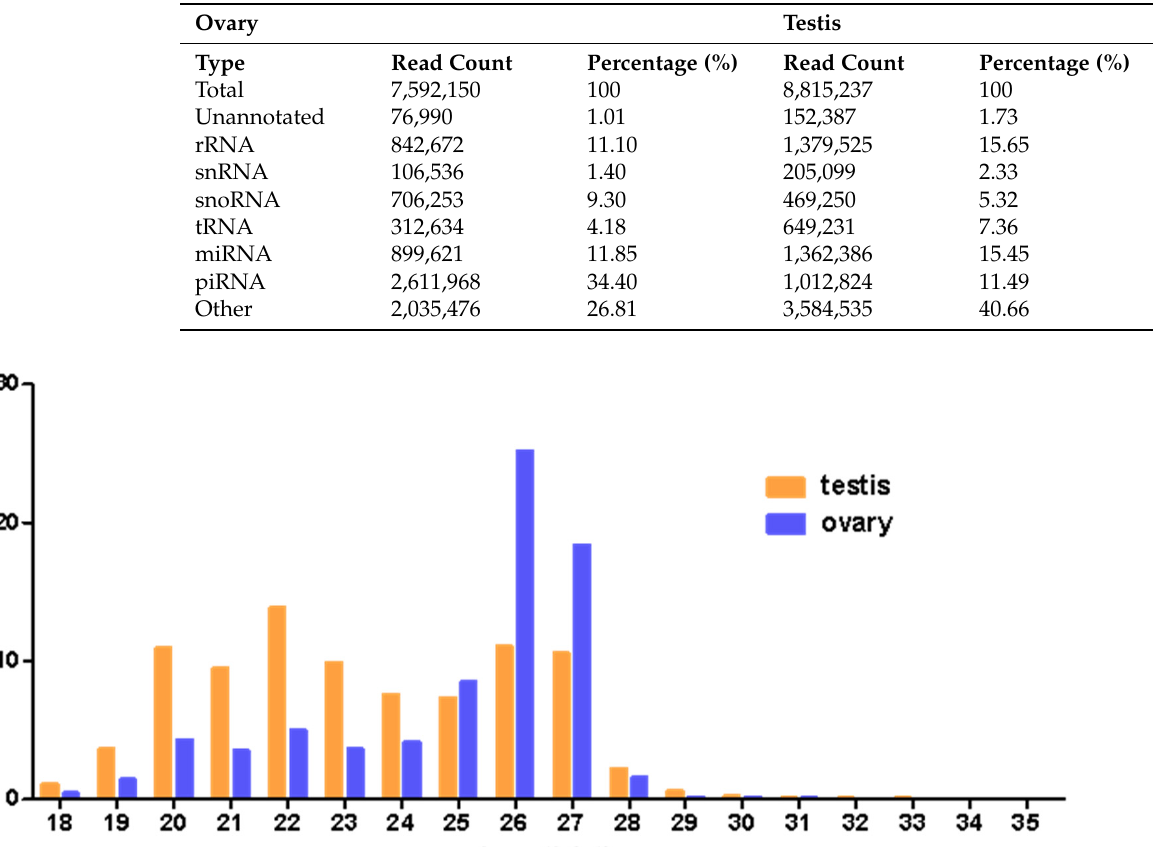
Table 1. Read counts and percentages of different types of small RNAs recovered from the ovary and testis small RNA libraries of H. armigera .